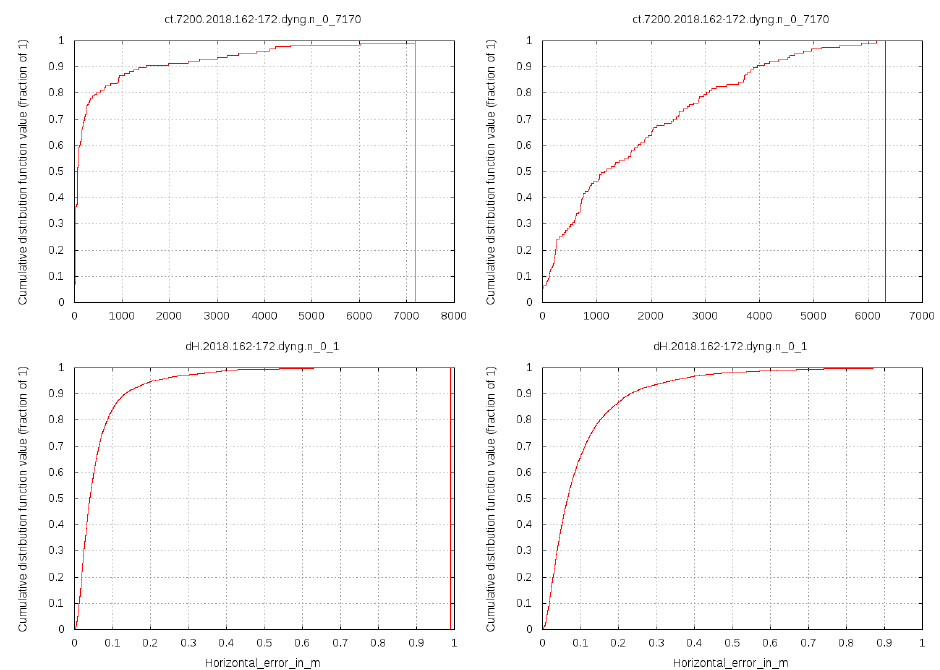
Figure 8. Summary of results for roving user DYNG. First row: Percentage of cumulative cases, over the 132 roving user resets between days 162 to 172, 2018, vs. convergence time for horizontal positioning error, in seconds. Second row: Corresponding final horizontal positioning error, in meters.